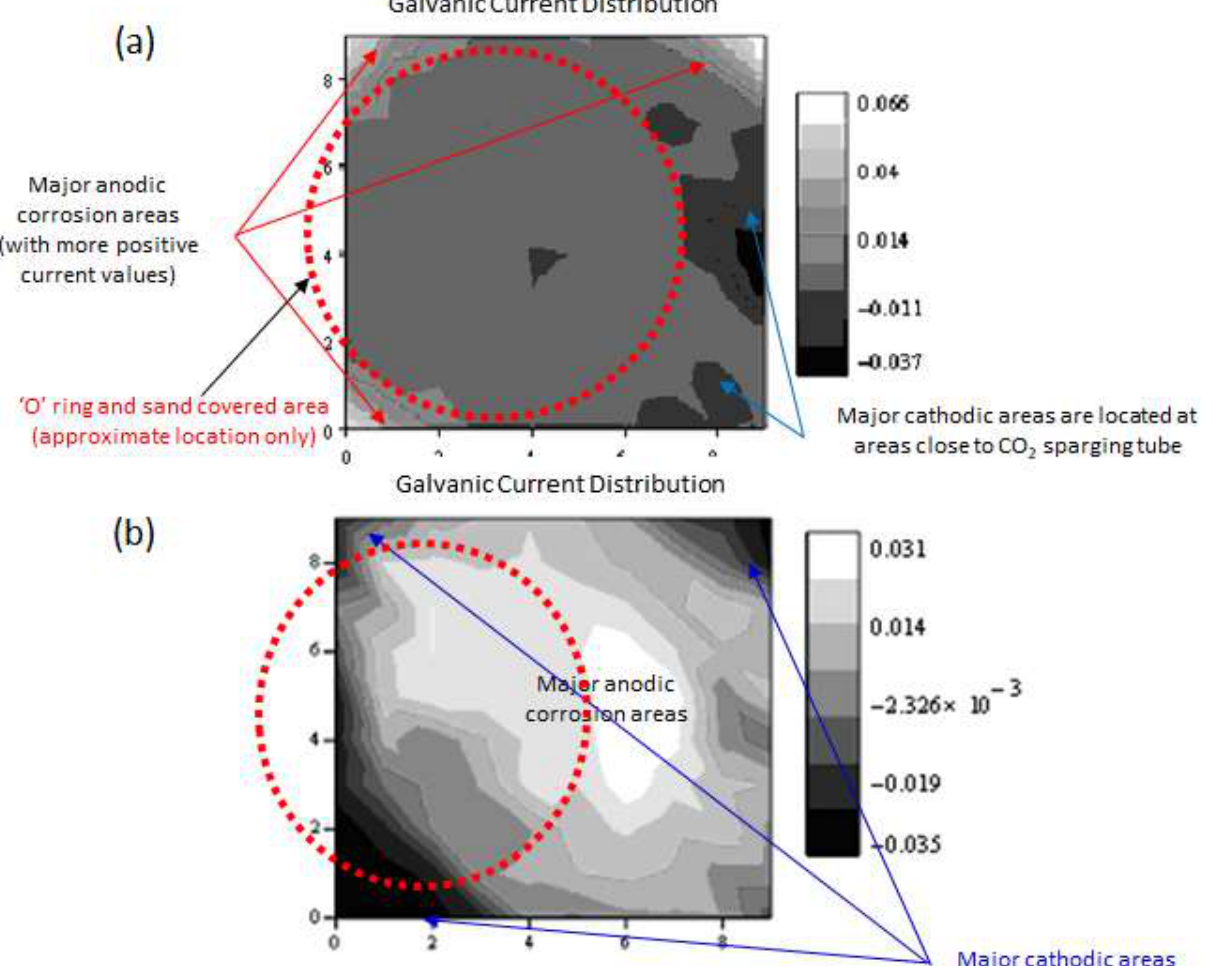
Figure 6. ( a ) Galvanic current distribution (in mA/cm 2 ) maps measured over a WBE exposed to a brine–CO 2 corrosion environment for 18 h without an inhibitor present, and ( b ) 97 min after 30 ppm of the inhibitor imidazoline was added into the system [87] . Reproduced with permission.